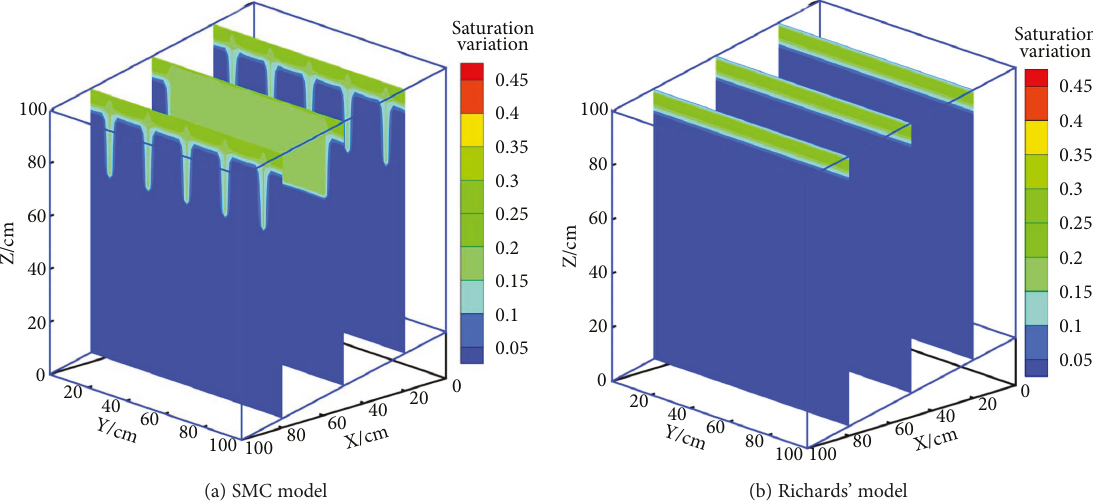
Figure 8: Comparison of the fl ow pattern simulated by the Richards and SMC model when t =12h.